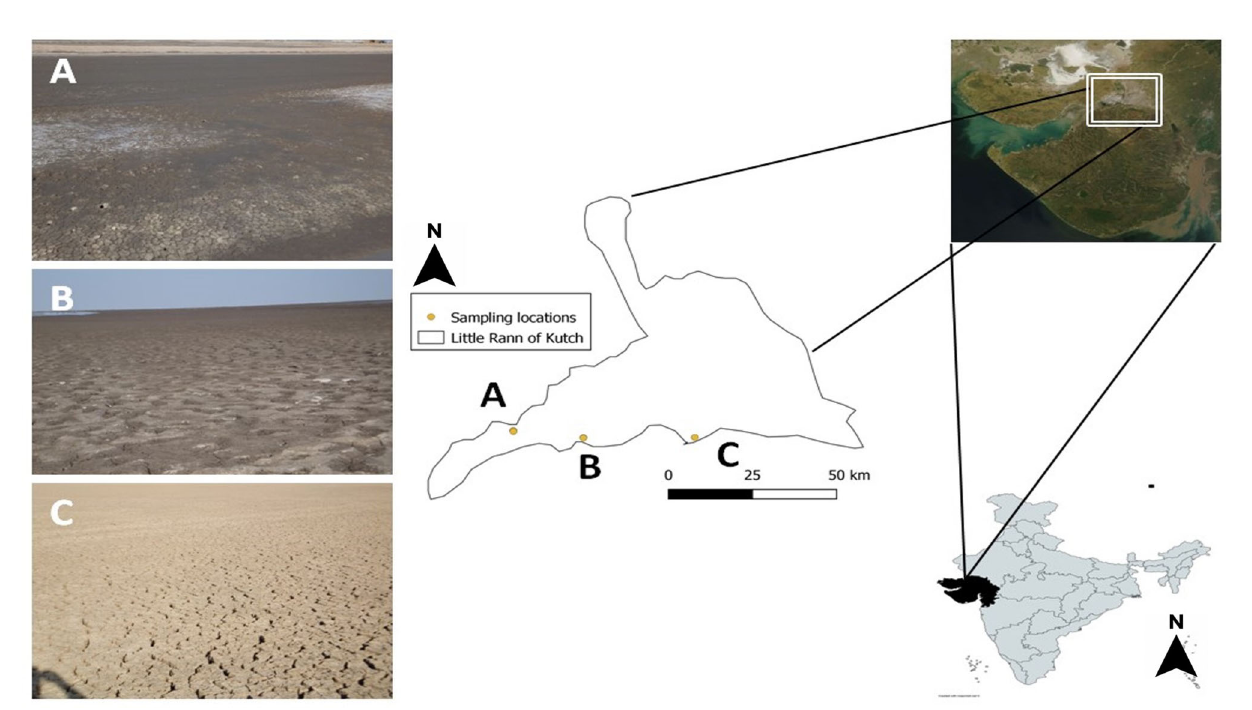
FIGURE 1 | Location map of sampling sites in Little Rann of Kutch, Gujarat, India. Dots and alphabets indicate the sampling sites: (A) Surajbari (N 23° 11 ’ 16.373, E 070° 43 ’ 03.929 ” ) (B) Venasar (N 23° 09 ’ 57.327 ” , E 070° 55 ’ 14.575 ” ) (C) Jogad (N 23° 10 ’ 38.992 ” , E 071° 15 ’ 04.999 ”